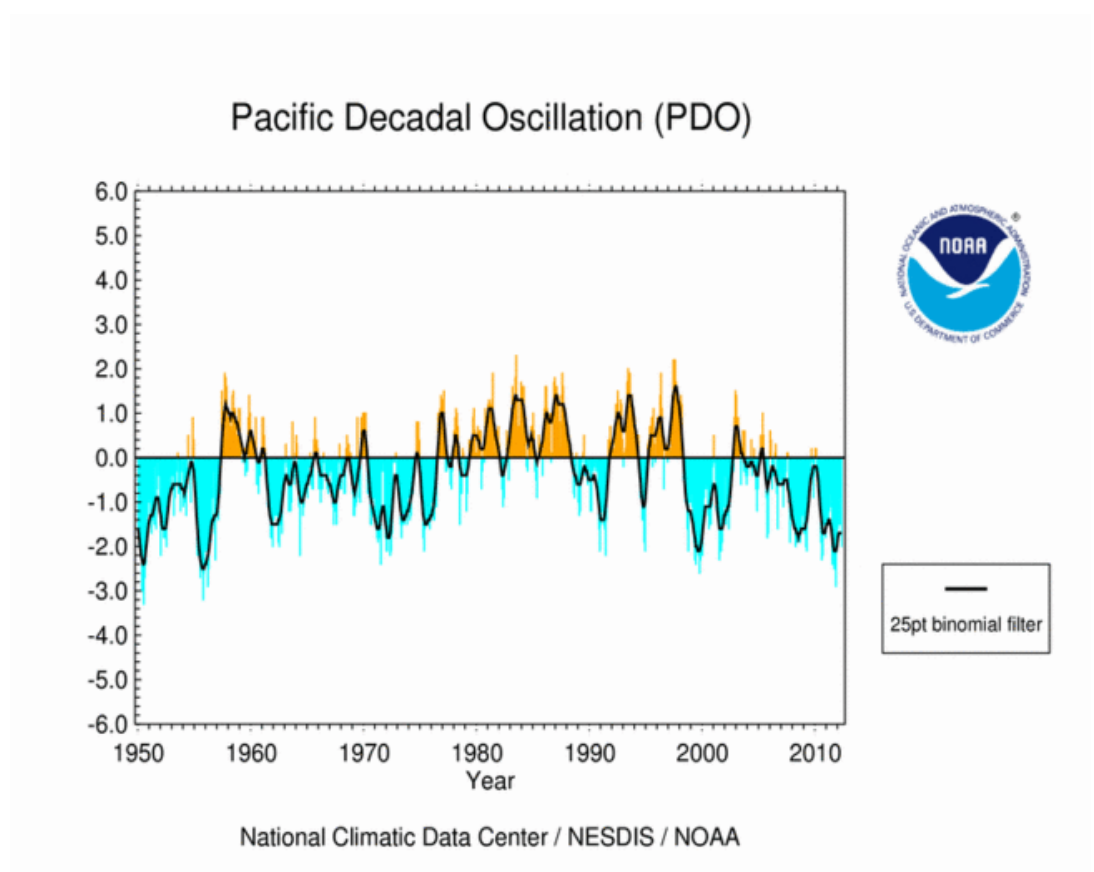
Figure 4. The Pacific Decadal Oscillation (PDO)